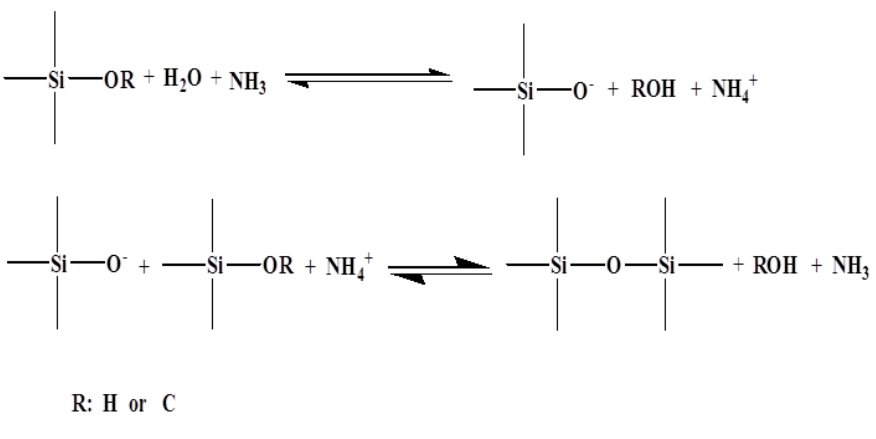
Figure 2. hydrolysis and condensation of TEOS in the Stober